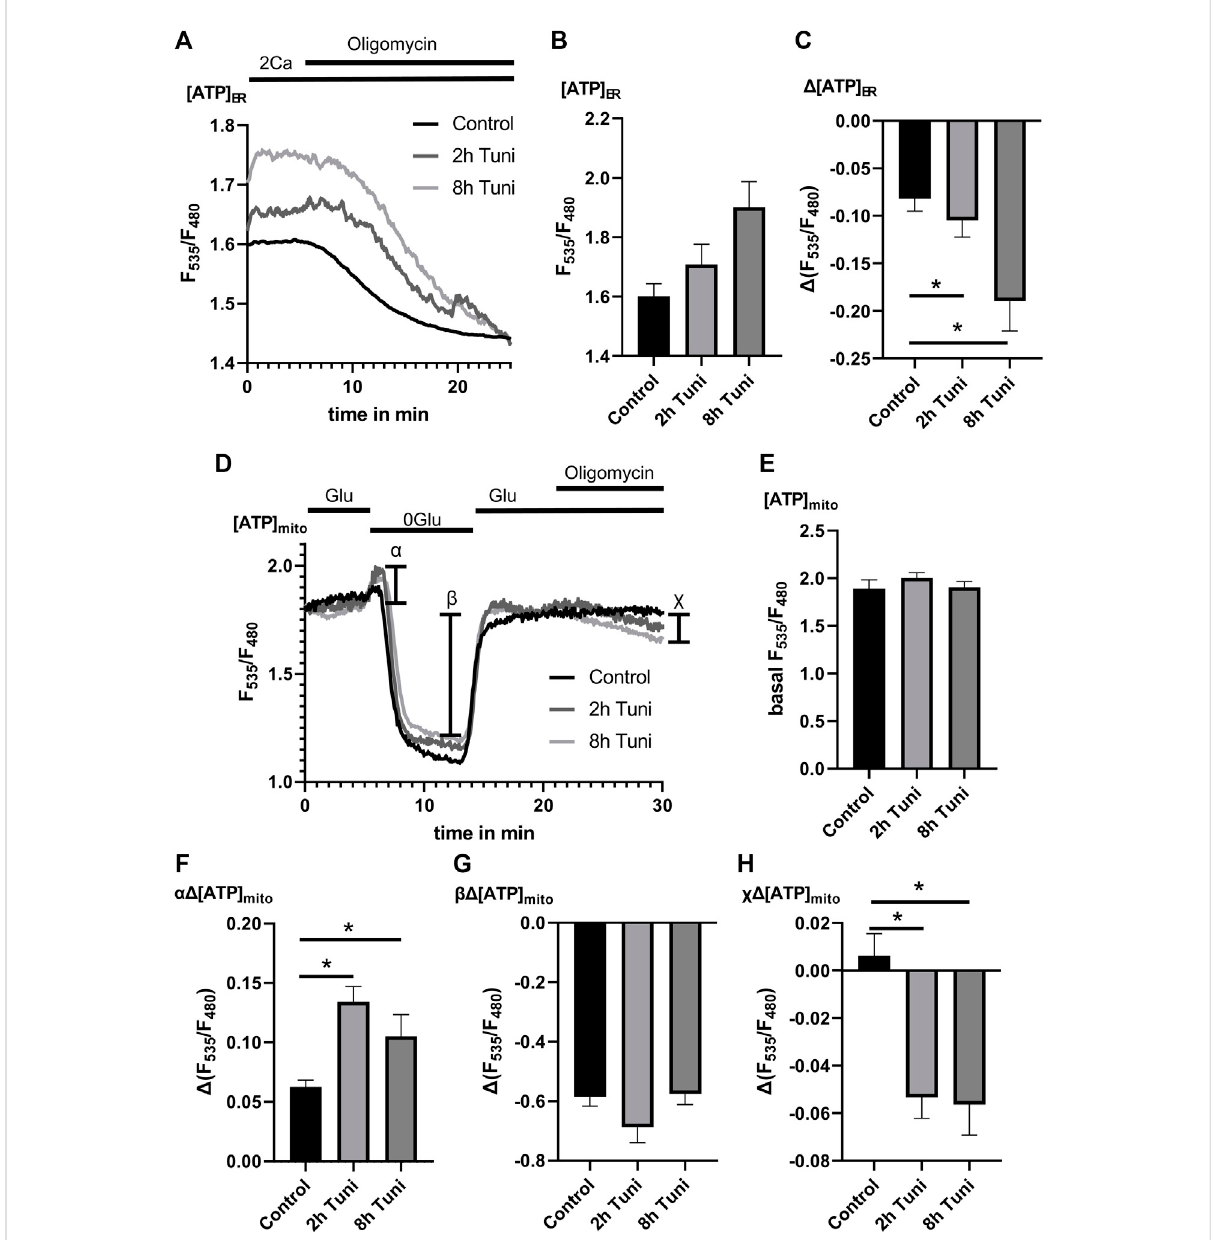
[ATP] mito and [ATP] ER are more dependent on oxidative metabolism under ER-stress. (A) HeLa cells expressing the endoplasmic reticulum targeted genetically encoded [ATP] ER sensor ERAT4.01 were used. Representative [ATP] ER traces upon Oligomycin challenging of control HeLa cells or HeLa cells treated with 0.6 µM tunicamycin for 2 h or 8 h. (B) Bar graphs (MEAN ± SEM) show basal [ATP] ER of control HeLa cells or HeLa cells treated with tunicamycin for 8 h. (C) Bar graphs (MEAN ± SEM) show Δ [ATP] ER upon challenging control HeLa cells ( n = 4/8/31) or HeLa cells treated with tunicamycin for 2 h ( n = 4/8/51) or 8 h ( n = 4/8/38) with oligomycin. (D) HeLa cells stably expressing the mitochondrial targeted genetically encoded [ATP] mito sensor mtAT1.03 were used. Representative [ATP] mito traces upon consecutive glucose removal, glucose re-addition andOligomycinadditionofcontrolHeLacellsorHeLacellstreatedwithtunicamycinfor2 hor8 h. (E) Bargraphs(MEAN±SEM)showbasal[ATP] mito of control HeLa cells or HeLa cells treated with tunicamycin for 2 h or 8 h. (F) Bar graphs (MEAN ± SEM) show initial Δ [ATP] mito induced by glucose removal [see α in (D)] of control HeLa cells or HeLa cells treated with tunicamycin for 2 h or 8 h. (G) Bar graphs (MEAN ± SEM) show Δ [ATP] mito induced by glucose removal (see β in (D) ) of control HeLa cells or HeLa cells treated with tunicamycin for 2 h or 8 h. (H) Bar graphs (MEAN ± SEM) show Δ [ATP] mito induced by the addition of oligomycin (see χ in (D) ) of control HeLa cells ( n = 3/6/64) or HeLa cells treated with tunicamycin for 2 h ( n = 3/6/41) or 8 h ( n = 3/6/37). * p < 0.05 vs. respective control conditions carried out with one-way ANOVA with Tukey corrected posthoc